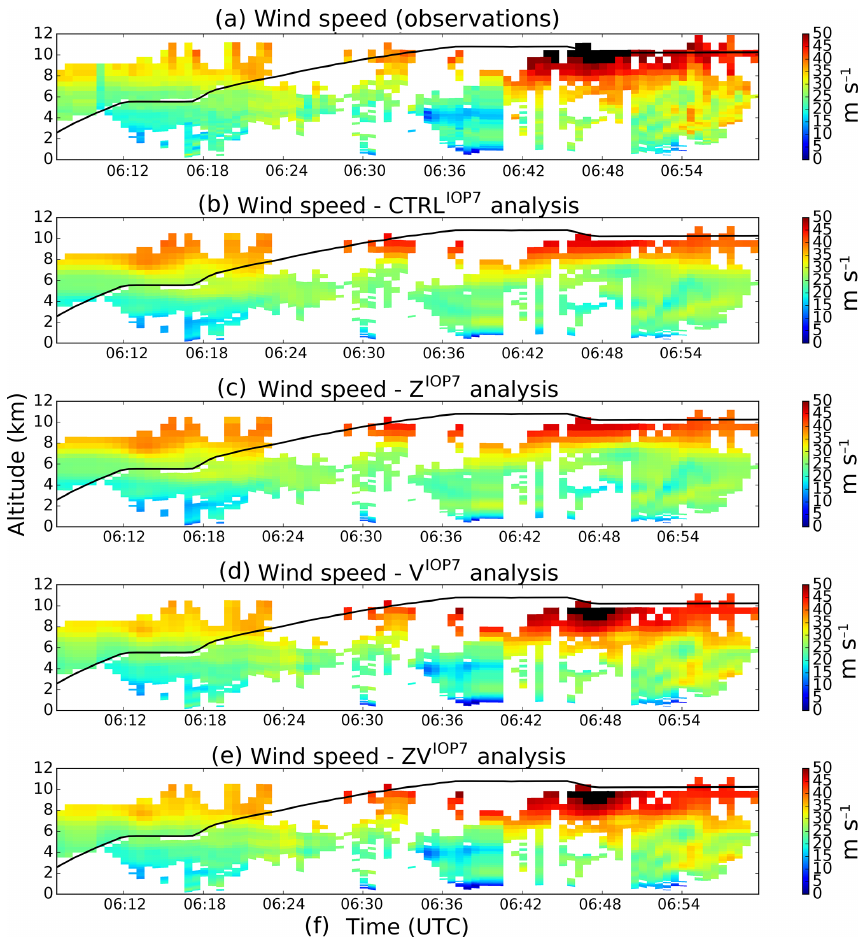
Figure 7. Wind speed (ms − 1 ) for (a) – (e) : the observations, the CTRL IOP7 , the Z IOP7 , the V IOP7 and the ZV IOP7